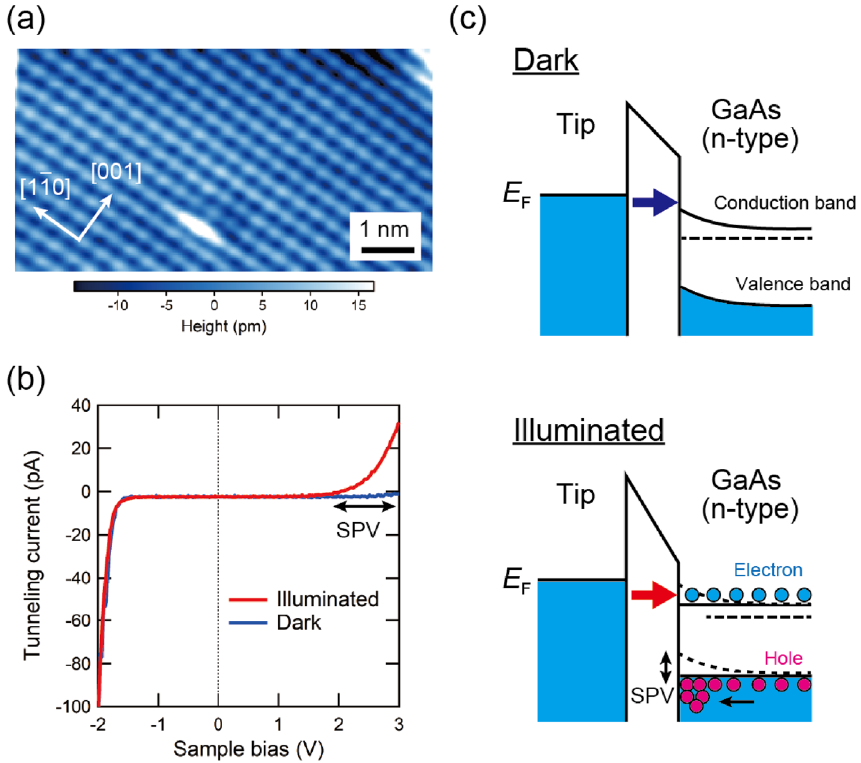
Figure 5. ( a ) Constant-current STM image of GaAs(110) surface. Set-point: sample bias voltage V = − 3 V, and tunneling current I t = 100 pA. T = 78 K. ( b ) I - V curves obtained with (red) and without laser illumination (blue). Set-point: V = − 2 V, I t = 100 pA. T = 78 K. ( c ) Schematic illustrations of the band structures of the n -type GaAs surface when V > 0 without (top) and with laser illumination